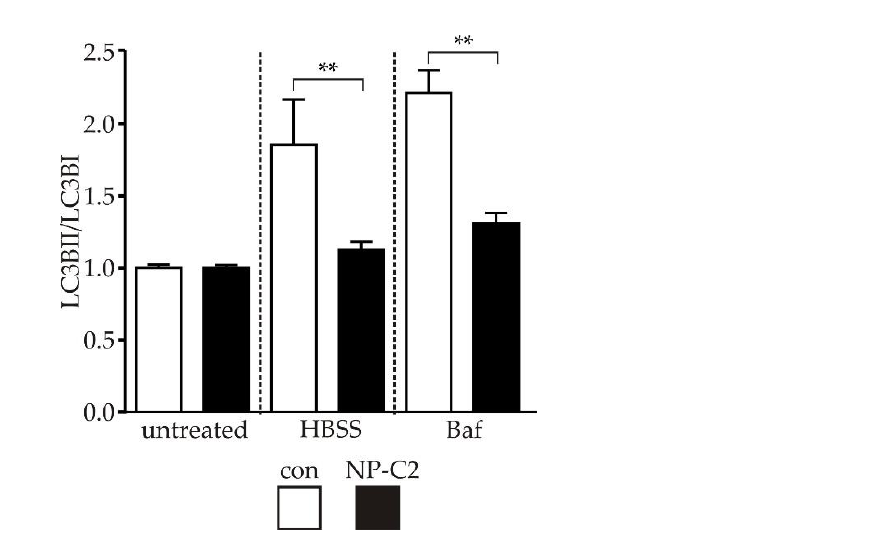
Figure 4. Evaluation of autophagy. To determine alterations of autophagy, the ratio of the level of LC3BII/LC3BI protein expression was analyzed by means of Western blot. Cells cultured under basal conditions (indicated as untreated) did not show a difference in the LC3BII/LC3BI ratio. Control cells cultured under condition of starvation (indicated as HBSS) showed increased LC3BII/LC3BI ratio, in contrast to NPC2-deficient cells. A comparable reaction of control cells was observed after the application of Bafilomycin A1 (Baf). Example of a complete Western blot membrane is shown in Figure S3. ** = p < 0.01